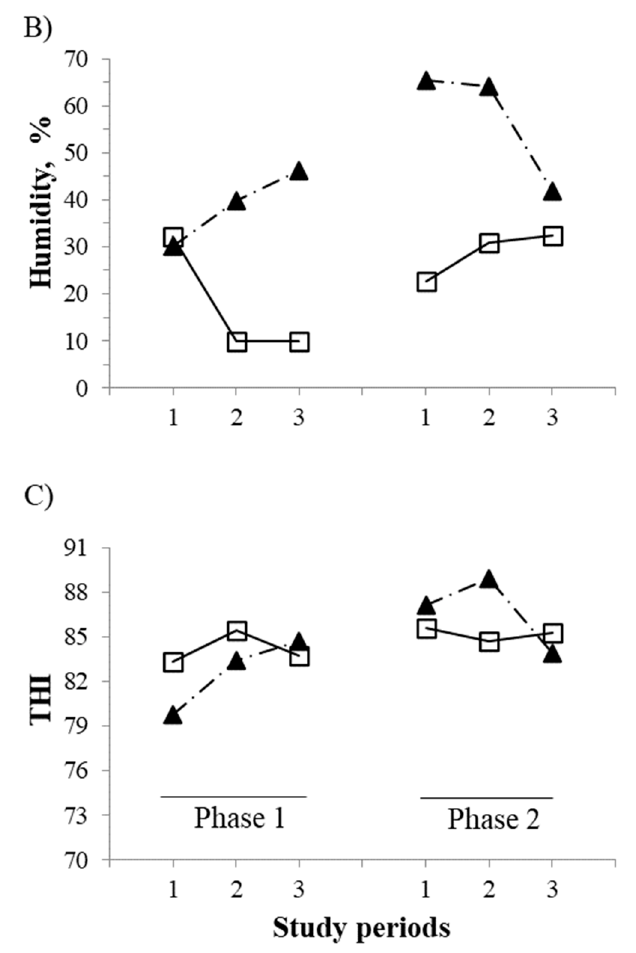
Figure 2. Average temperature ( A ), relative humidity ( B ), and temperature humidity index (THI) ( C ) values for the three study periods in each phase. Shaded triangle represents the inside pen and plain square represents the outdoor open area. Phase 1 lasted for 21 days from 16 May to 5 June and phase 2 from 10 June to 30 June.